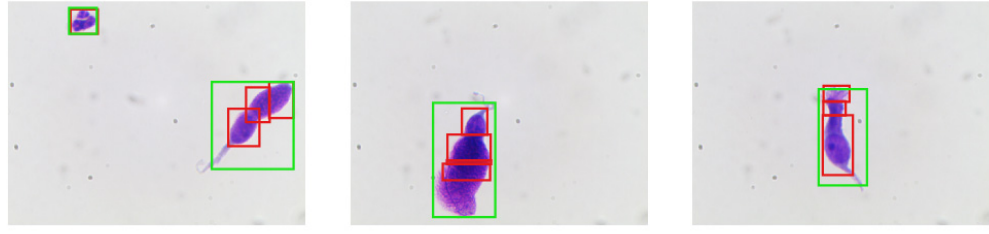
Figure 7. Some examples of the splitting problem. Each ciliated cell (green bounding box) is detected in three different regions (red bounding boxes). Since the three regions cover more than 75% of the cell area, these are counted as true positives.